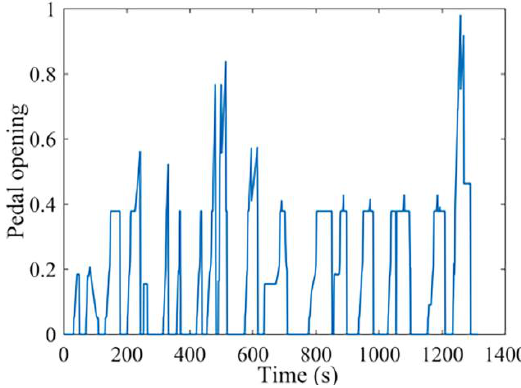
Figure 20. Pedal opening.